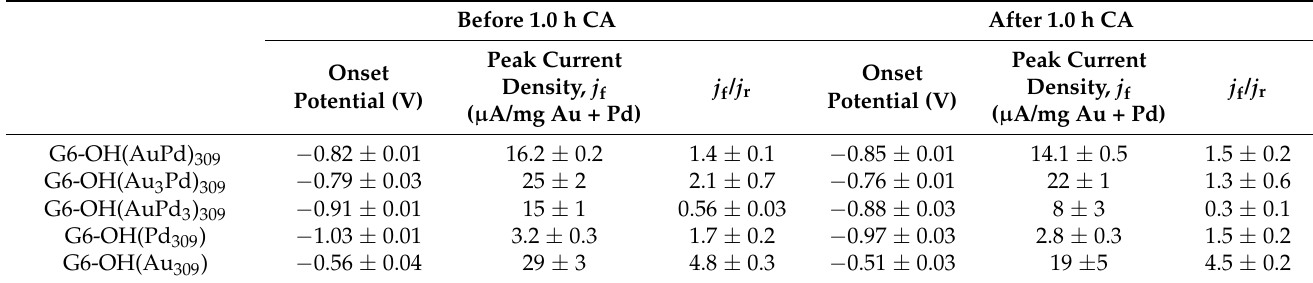
Table 2. Results extracted from electrocatalytic EOR CVs for DEN catalysts both before and after a 1.0 h CA. The first three columns correspond to the values for CVs collected before the 1.0 h CA. The first column provides the EOR onset potential (defined as the potential at which the current density is 10% of the forward peak current density, j f ). The second column lists the forward peak current density, j f . The third column shows the ratio of the forward to reverse catalytic peak current densities ( j f / j r ). The fourth, fifth, and sixth columns provide the same parameters, but for CVs collected following a 1.0 h CA. CVs were carried out at a scan rate of 50 mV/s in a N 2 ‐ satd., 1.0 M KOH solution containing 0.50 M ethanol and background subtracted using the background CVs in Figure S1. Standard deviations are based on three independent experiments. Before 1.0 h CA After 1.0 h CA Onset Potential Peak Current Peak Onset Onset j f /j r Density, j f Potential (V) Potential (V) ( µ A/mg Au + Pd)